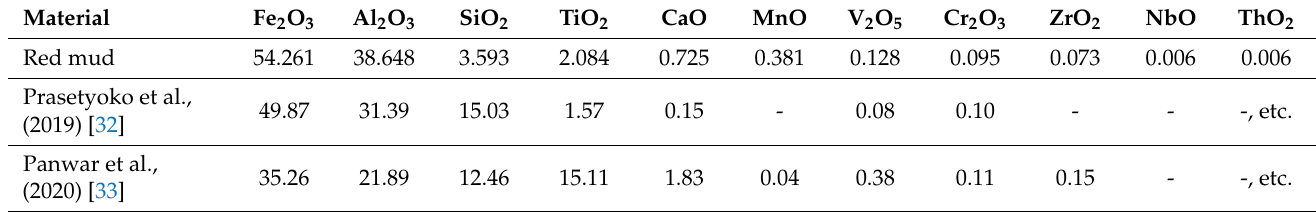
Table 1. Physical properties of the materials.